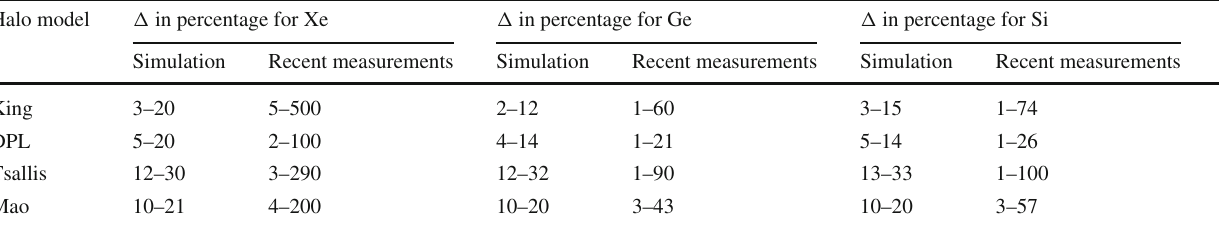
Fig. 5 Variations in the exclusion bounds for Tsallis with F DM = 1. All the relevant details are same as of Fig. 3 Table 3 A comparison of the uncertainties between APOSTLE DMB simulations for DPL, King, Tsallis, and Mao distributions and in the observed estimates of v 0 and v